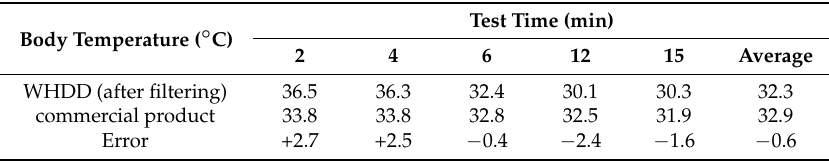
Table 9. Comparison between body temperatures measured with WHDD and with a commercially available infrared temperature gun during running.